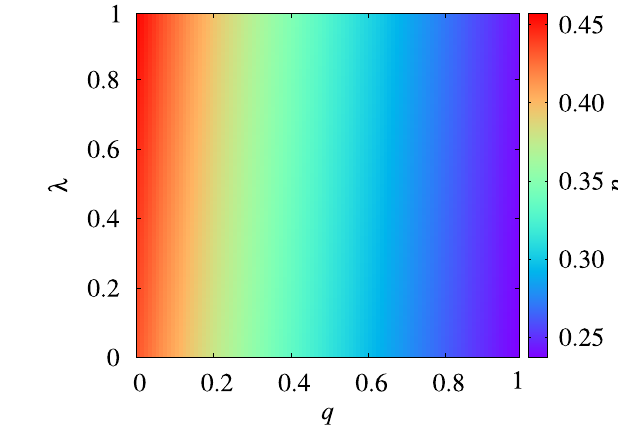
Fig. 4 The number of p versus q and λ with E = 0 . 966 and l = 4 In order to reveal the degeneracy for the periodic orbits, Fig. 5 shows some examples of the bound orbits around the black-bounce-Reissner–Nordström spacetime with various E but a fixed l = 3 . 98 where ( X , Y ) are defined as